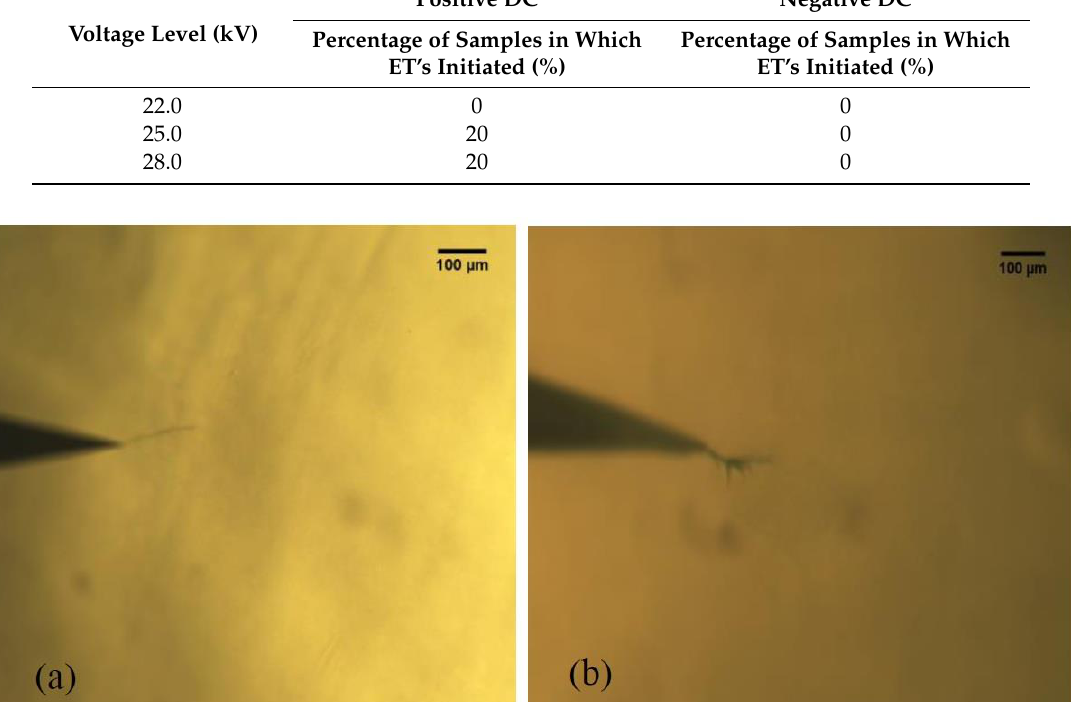
Figure 4. Development of electrical treeing (ETs) at direct current (DC) voltage ( a ) + 28 kV and ( b ) − 28 kV [23].